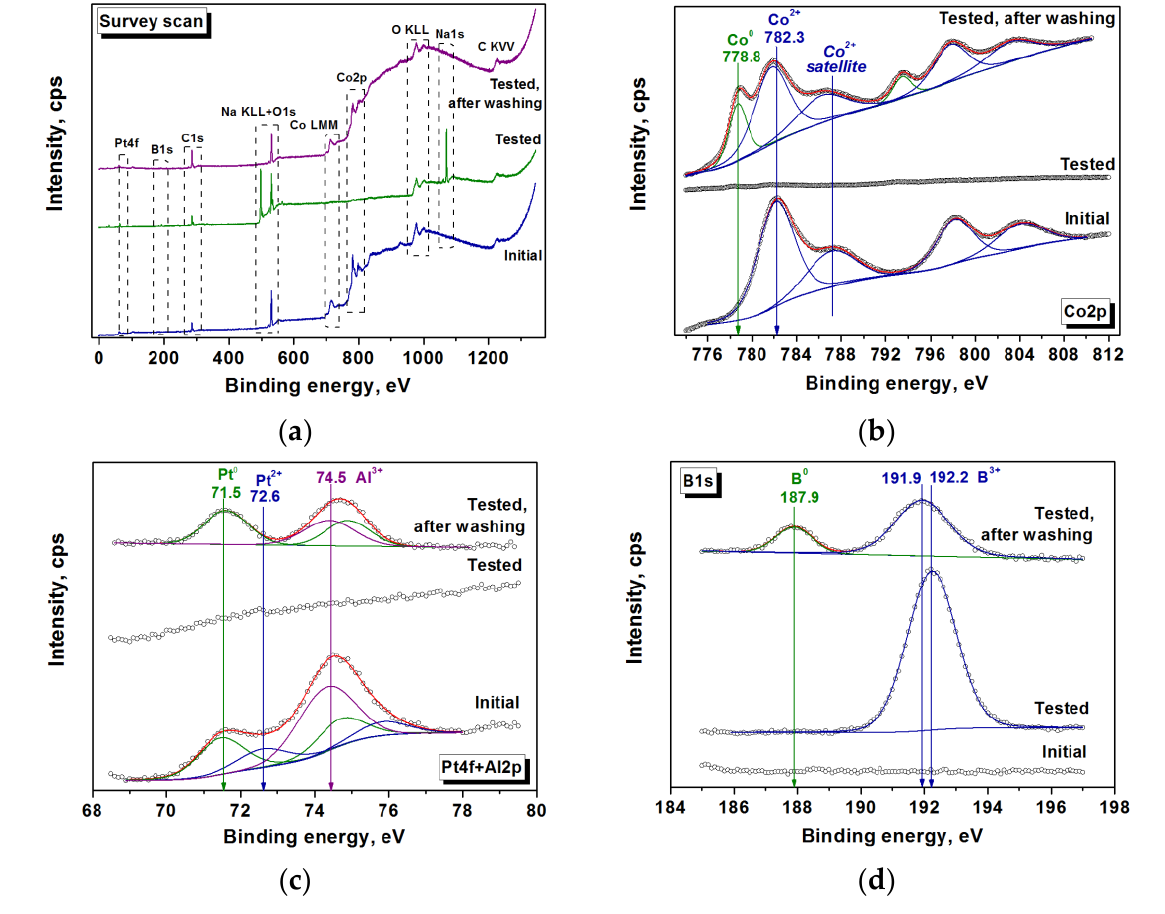
Figure 9. XPS data for the Pt 0.2 Co 99.8 sample: initial and after testing in 10 cycles of the NaBH 4 hydrolysis without and with water washing. Survey spectra ( a ), deconvolution of Co 2p spectra ( b ), Pt 4f + Al 2p spectra ( c ), and B 1s spectra ( d ).